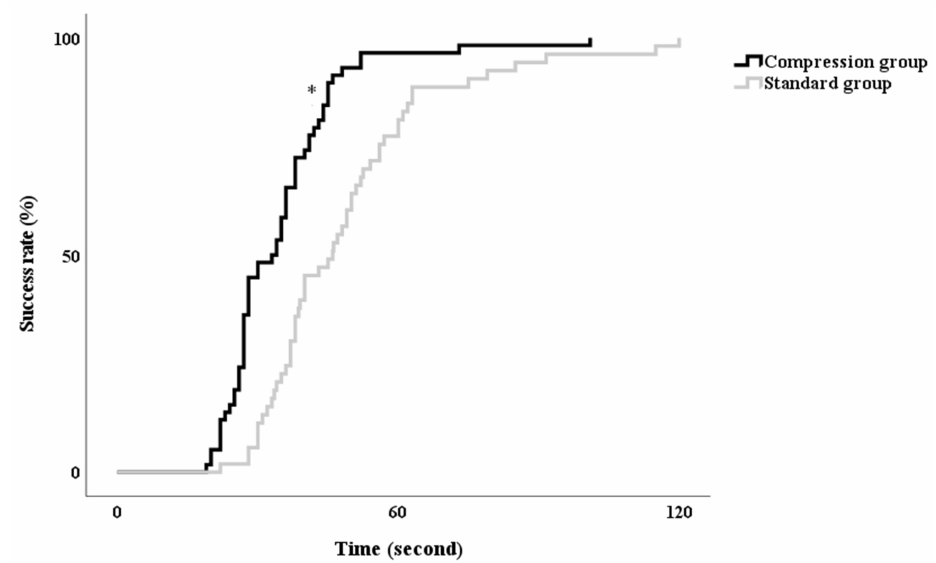
Figure 2. Kaplan–Meier estimator for success time of the radial artery catheterization. * p < 0.05 compared with Standard